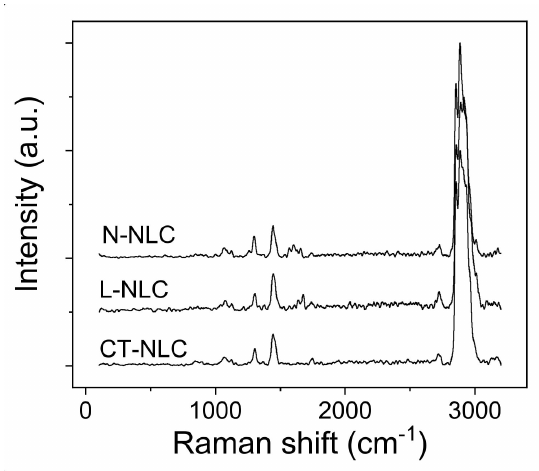
Figure 3. Raman spectra of L-NLC, CT-NLC, and N-NLC.